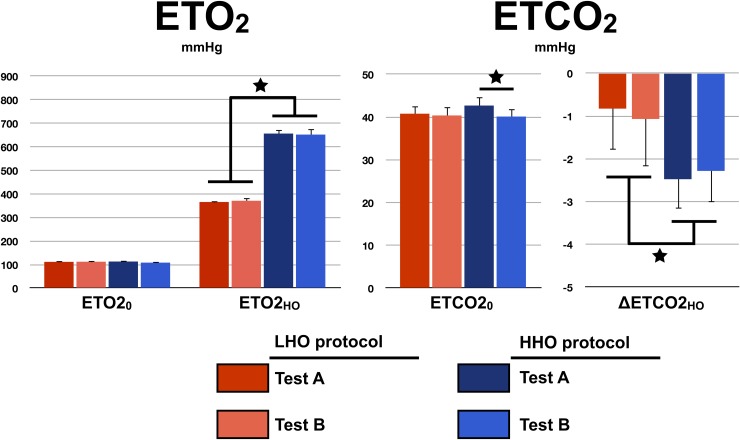
Gas manipulation.For each protocol and test, the measured resting (with the subscript ‘0’) and hyperoxic (with the subscript ‘HO’) end-tidal O2 and CO2 are presented. Errors bars indicate standard deviation. A star indicates a significant difference at P < 0.05.